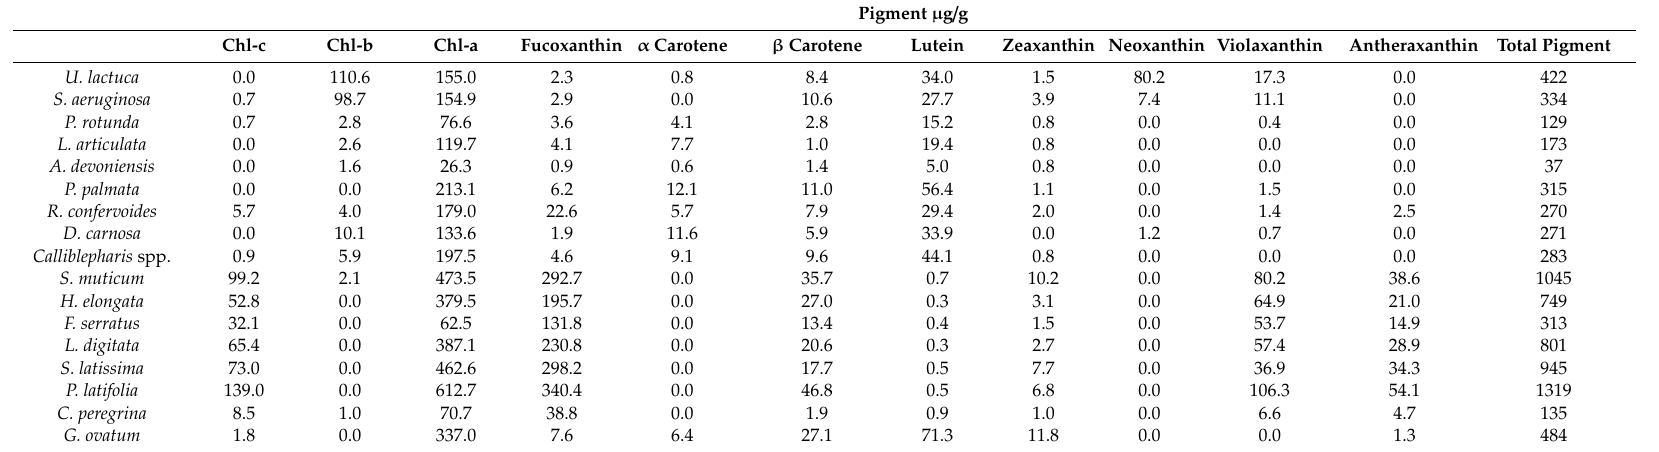
Table 3. Primary pigments of South West seaweed samples ( µ g / g dry biomass). Chlorophyll (chl)–c is given as the total of C-1, 2 and 3